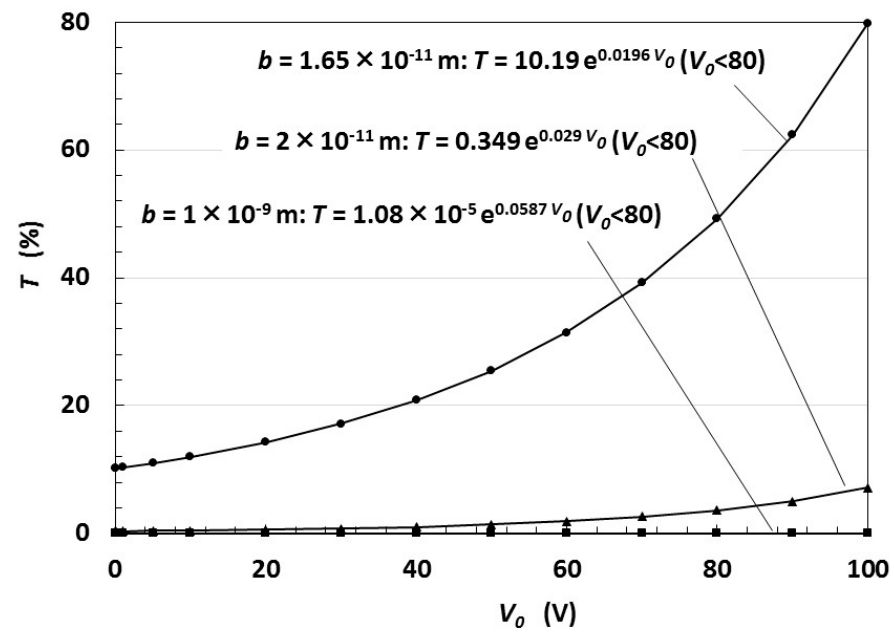
Figure 4. Theoretical results of the transmitted probability T with respect to applied external voltage V o in relation to the thickness b of nonconductive rubber between the metal or Fe 3 O 4 particles.